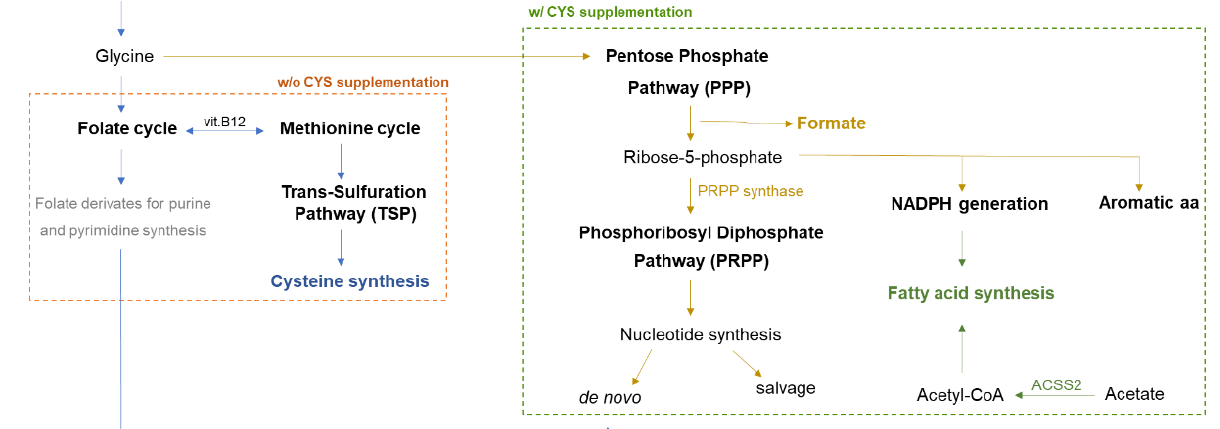
Figure 1. Cysteine supplementation may be involved in the promotion of cell proliferation in monocytes, abrogating differentiation. In environments with increased cysteine bioavailability, the glycine flux will be deviated to the pentose phosphate pathway (PPP), increasing the levels of ribose-5-phosphate (R5P) that contributes to nucleotide synthesis through the phosphoribosyl diphosphate pathway (PRPP). Since the nucleotide synthesis ( de novo or savage) is dependent on ribose-5-phosphate for the PRPP, the shuttle from the folate/methionine cycle to the PPP will favor nucleotide demands essentially for cell proliferation. Although folate byproducts are needed for de novo nucleotide synthesis, PRPP is the rate-limiting reaction. In theory, proliferating cells will favor the PPP instead of the folate/methionine cycle to sustain the PRPP through R5P. Moreover, the more active PPP leads to more formate production (metabolite increased in cysteine-supplemented monocytes), and NADPH generated from the PPP will supply fatty acid synthesis and acetyl-CoA derived from acetate (metabolite decreases in cysteine-supplemented monocytes).